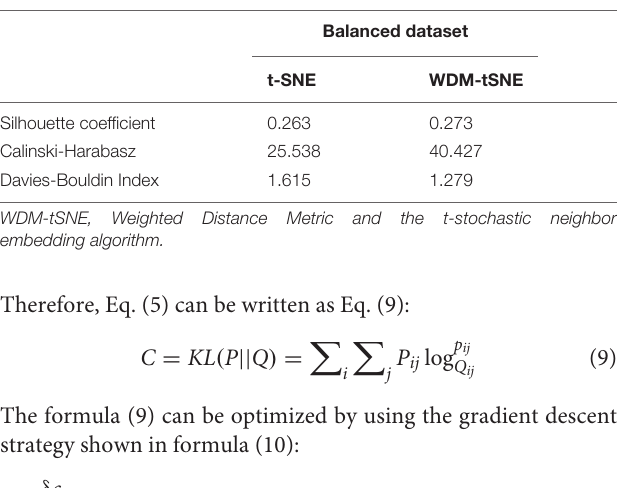
TABLE 3 | The performance of WDM-tSNE on the dataset of tomato